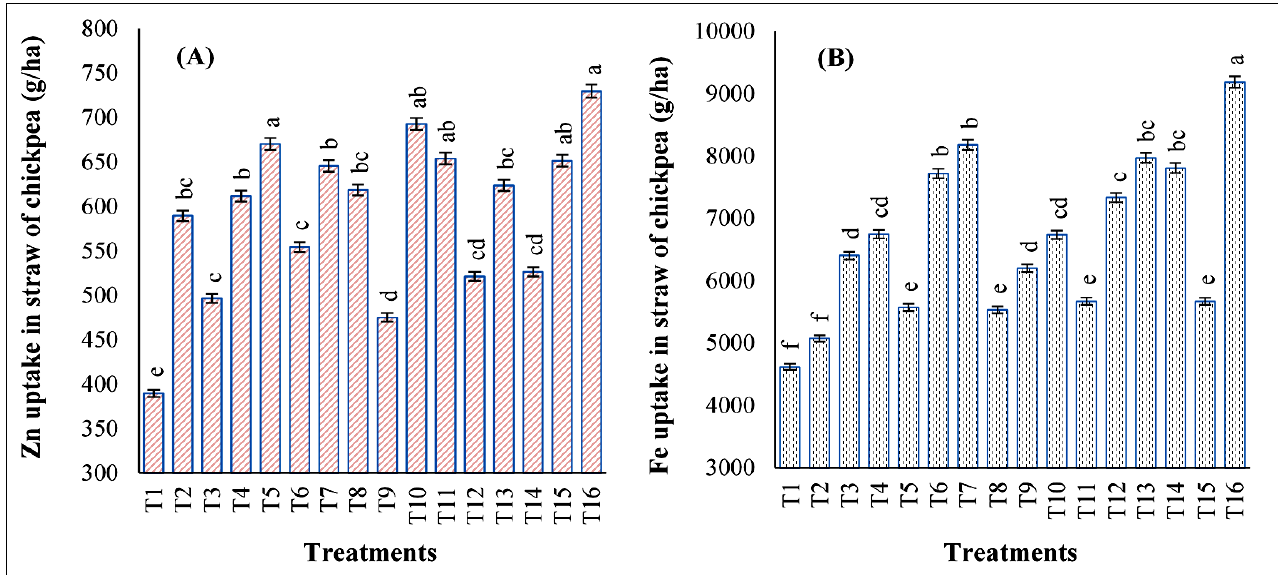
Figure 3. Effect of mineral, chelated and nanoforms of ( A ) Zn and ( B ) Fe on uptake of Zn and Fe in the straw of chickpea. In each bar, means with a similar or dissimilar letter(s) were evaluated with the least significant difference (LSD) multiple range test, using a probability level of p ≤ 0.05.